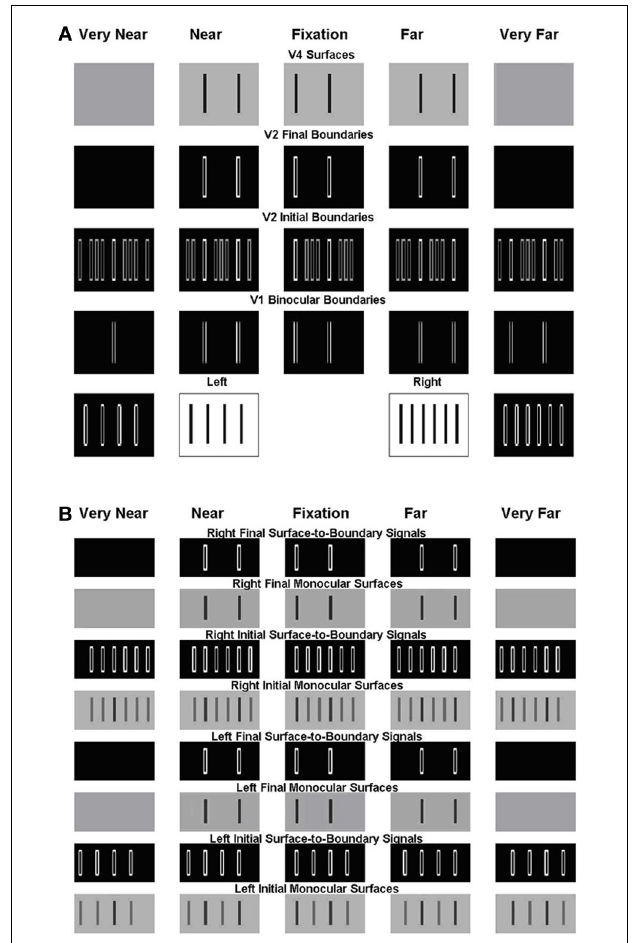
FIGURE 6 | Simulation of the Venetian blind effect in Howard and Rogers (1995). The variables that are plotted in this and other simulations correspond to the model processing stages shown in Figure 2 , and the corresponding mathematical variables shown in Figure 1 . (A) The two middle plots of the bottom row are the Left Eye Inputs and the Right Eye Inputs, respectively. The two outer plots in the bottom row are the Left Monocular Boundaries that are computed at the Left Eye V1 Monocular Complex Cells and the Right Monocular Boundaries that are computed at the Right Eye V1 Monocular Complex Cells, respectively. The plots in the third row from the bottom are the Initial Binocular Boundaries that are computed in V2 Layer 4. The plots in the fourth row from the bottom are the Final Binocular Boundaries that are computed in V2 layer 2/3. The initial boundaries in V2 layer 4 are computed before the Surface-to-Boundary feedback signals act (see S-to-B in Figure 2 ). The final boundaries are computed after all the boundaries equilibrate to the Surface-to-Boundary feedback signals. The plots in the top row are the V4 Binocular Surfaces. (B) These simulation figures show the Left and Right, Initial and Final, Monocular Surfaces and Surface-to-Boundary Signals. As in (A) , Initial values are computed before the Surface-to-Boundary feedback signals act. Final values are computed after all the surfaces equilibrate to the Surface-to-Boundary feedback signals. See text for further